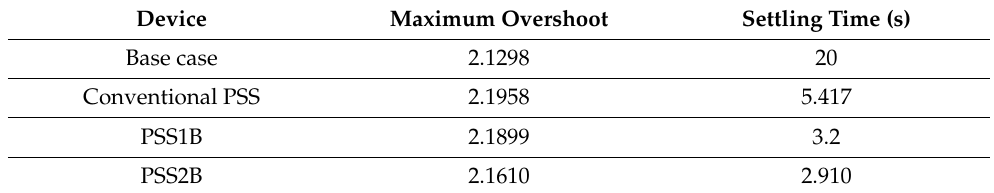
Table 12. Maximum overshoot and settling time of rotor angle at normal loading.